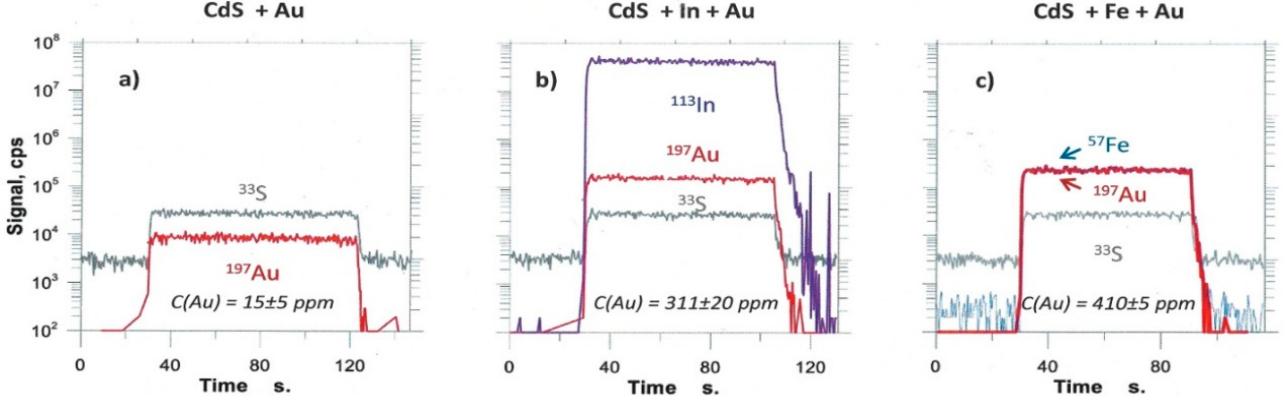
Figure 41. LA-ICPMS line mode spectra of the line ablated through the samples of CdS with admixtures of gold ( a ) sample 5457, indium and gold ( b ) sample 5459, iron and gold ( c ) sample 5458.